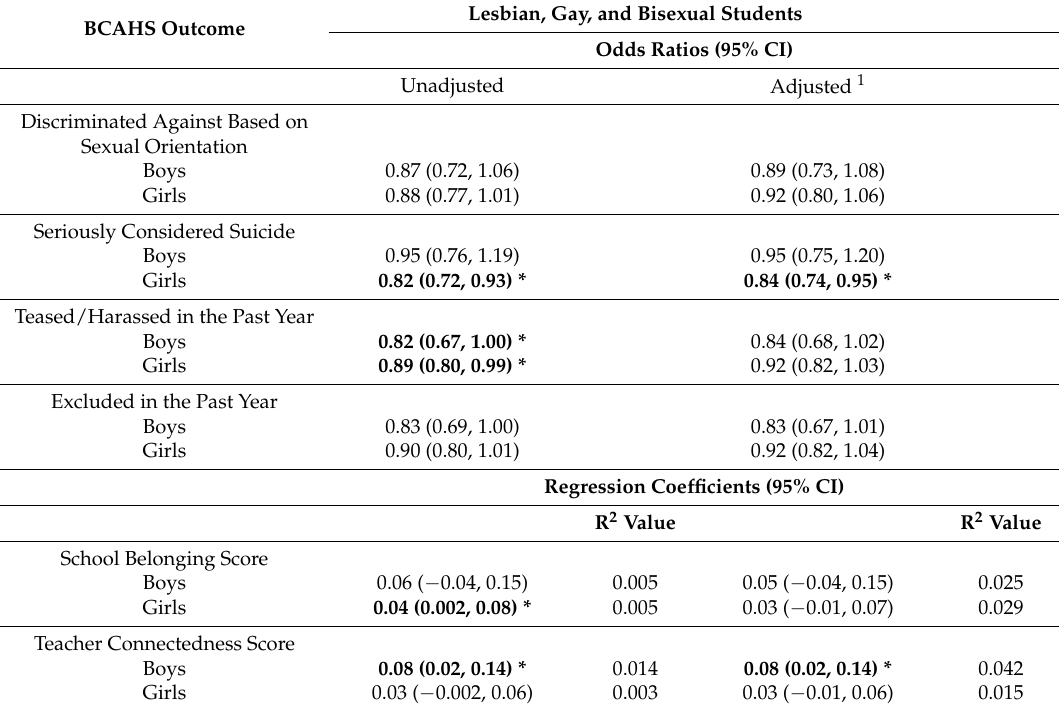
Table 5. Relationship between BC Adolescent Health Survey health outcome measures and the number of Out in Schools events hosted per school during the 2013 BCAHS cycle (2009–2013), for lesbian, gay, bisexual and completely heterosexual